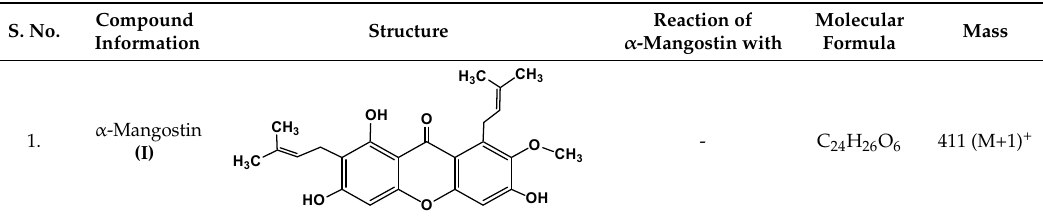
Table 1. α -Mangostin and its synthetic derivatives.